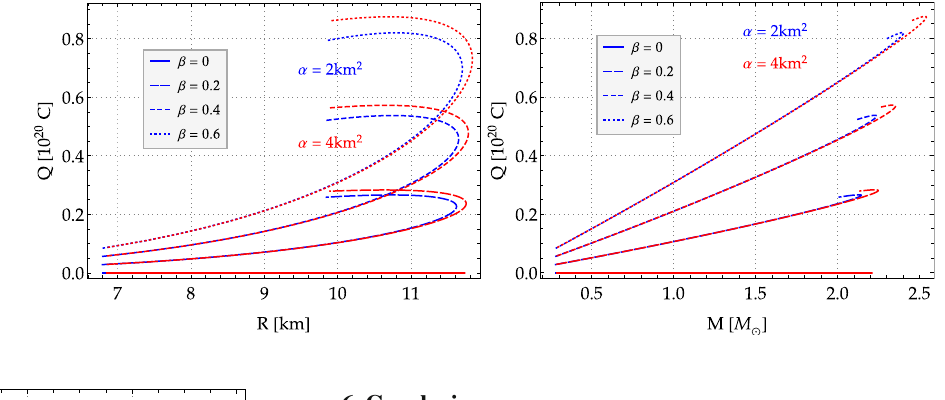
mass of quark stars undergoes slight changes at low central densities and the most significant deviations occur at higher densities due to the charge and GB coupling constant. The stable quark stars on the mass– central density curves in the right panel are found in the region where